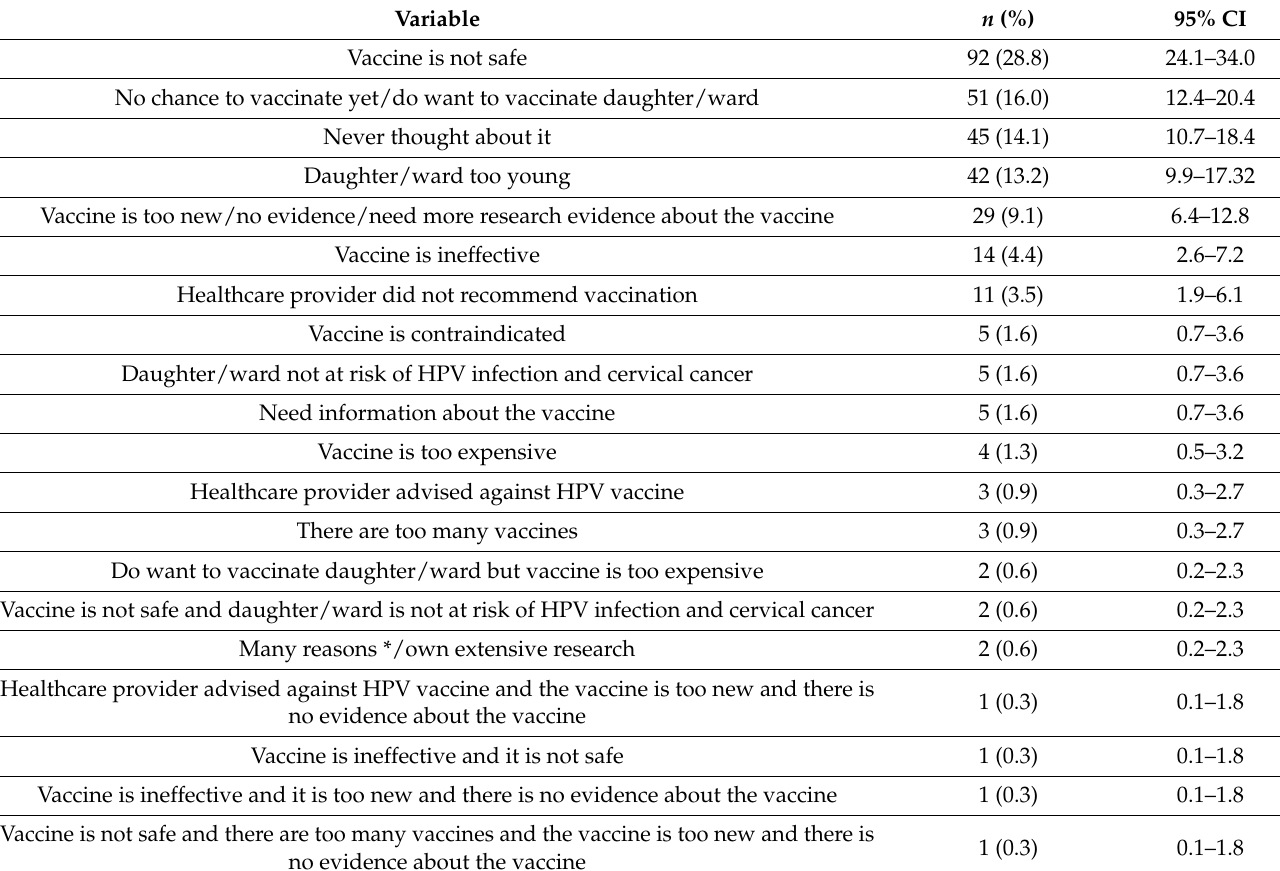
Table 2. Frequency distribution of caregivers’ reasons for being unsure or not wanting to vaccinate following coding of the “other” free text reasons ( n =